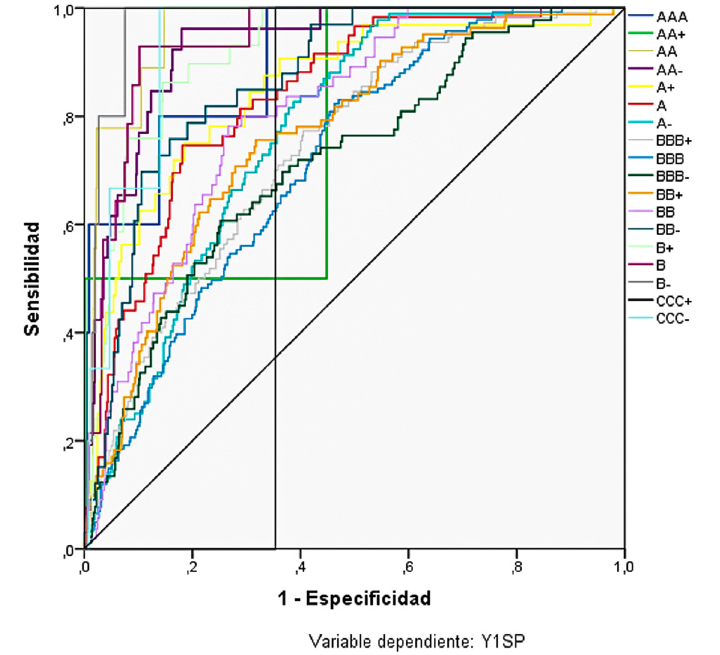
Figure 2. ROC curve for the S&P prediction model with sample